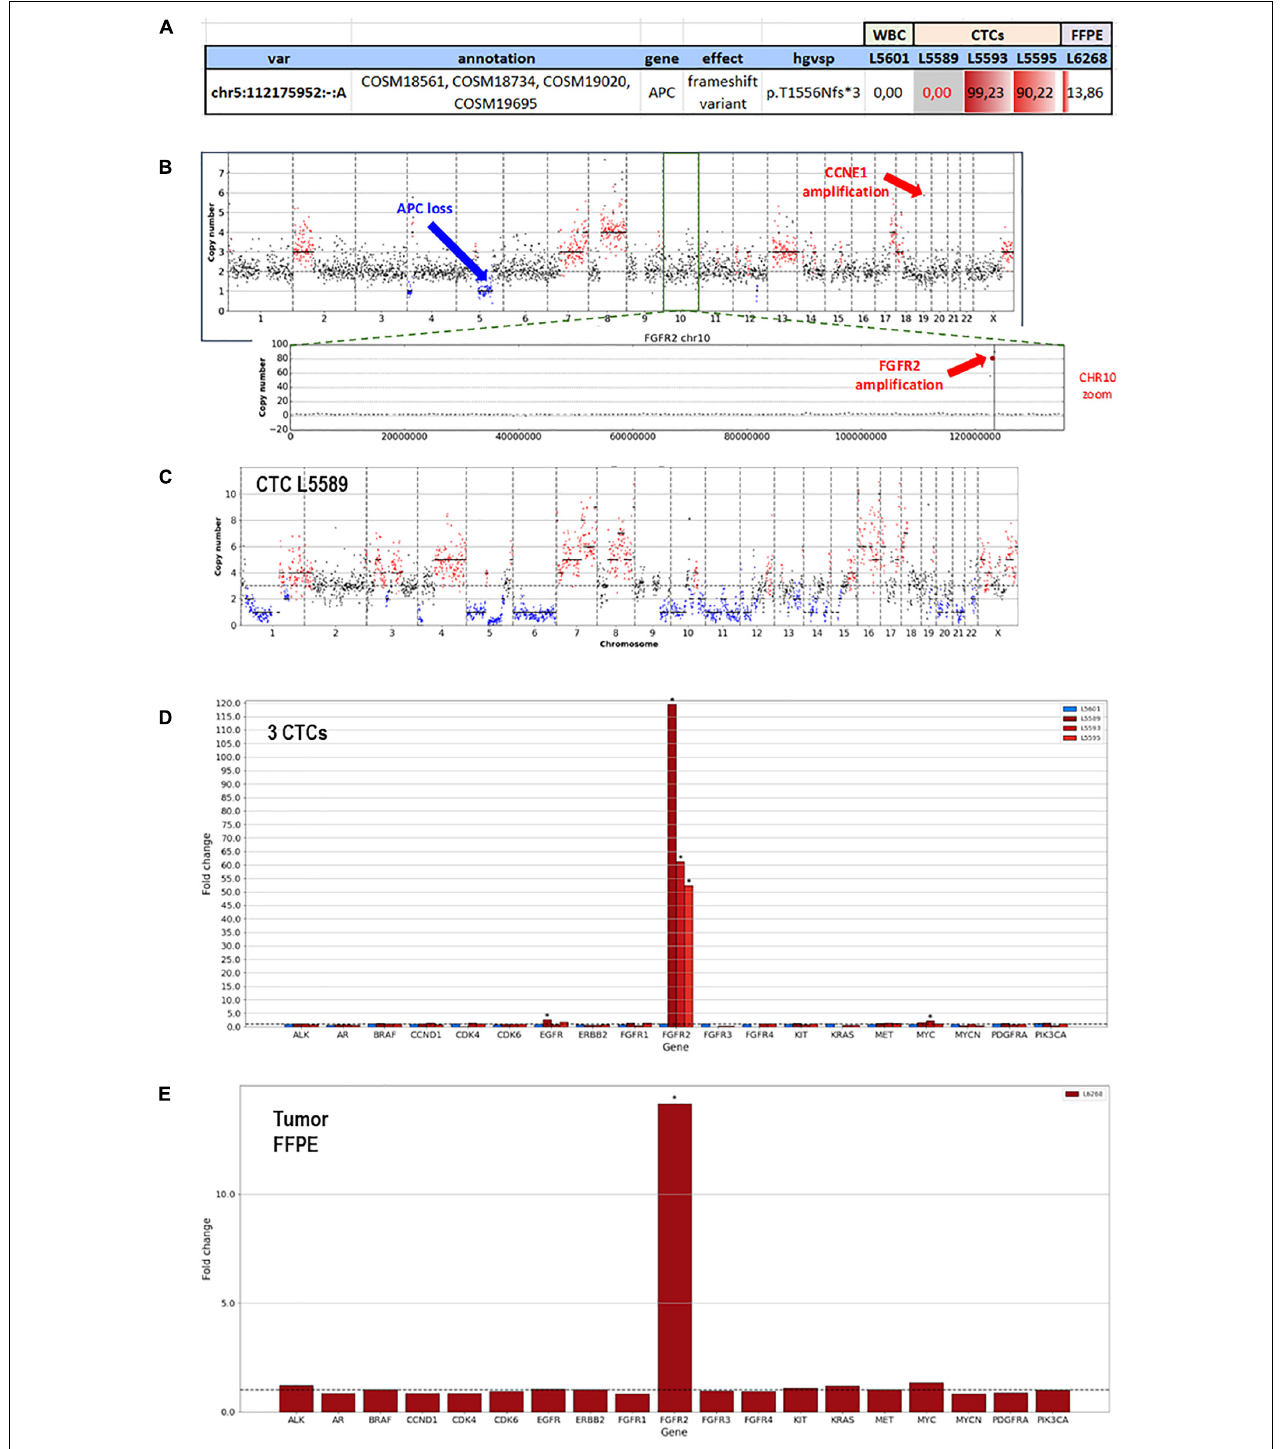
FIGURE 3 | Whole-genome copy number profiles and mutation analysis of CTCs and FFPE gDNA from patient #71. (A) Detection of a homozygous somatic variant (absent in a single WBC), in two out of three CTCs in APC gene (APC:p.T1556Nfs*3), a region also subjected to LOH, and the detection of the same variant in the FFPE tissue at lower frequency, due to the possible contamination by normal cells. (B) Representative copy number profile of one CTC. Amplification signal was detected for FGFR2 and CCNE1 genes, indicated with red arrows. The LOH region in chromosome 5, comprising the APC gene, is indicated with a blue arrow. (C) LowPass profile of L5589 CTC showing the complete deletion of APC genomic region, in agreement with the lack of coverage in targeted sequencing (grayed out in A ). (D) Copy number aberration (CNA) distribution showing FGFR2 amplification in all three CTCs (D) and FFPE biopsy (E) .